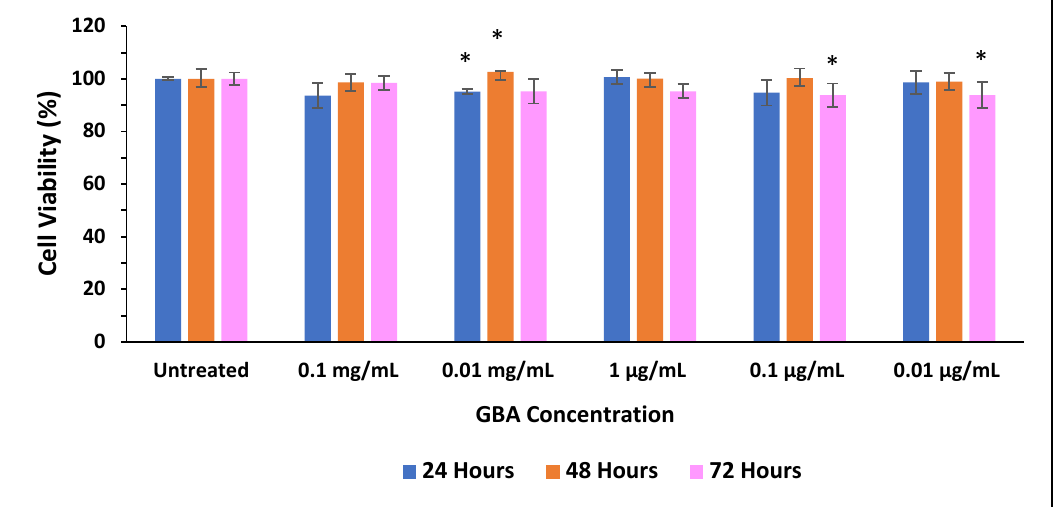
Figure 6. Effect of GBA on MCF-7 cell viability. Approximately 50,000 cells were seeded per well, and after 24 h, they were treated with GBA in DMEM. 3-4, 5-Dimethylthiazol-2-yl-2, 5-diphenyltetrazolium bromide (MTT) assay was performed after 24, 48, and 72 h. Cell viability was measured as compared to untreated cells. p values between 0.01 and 0.05 (*) were represented to be significant.